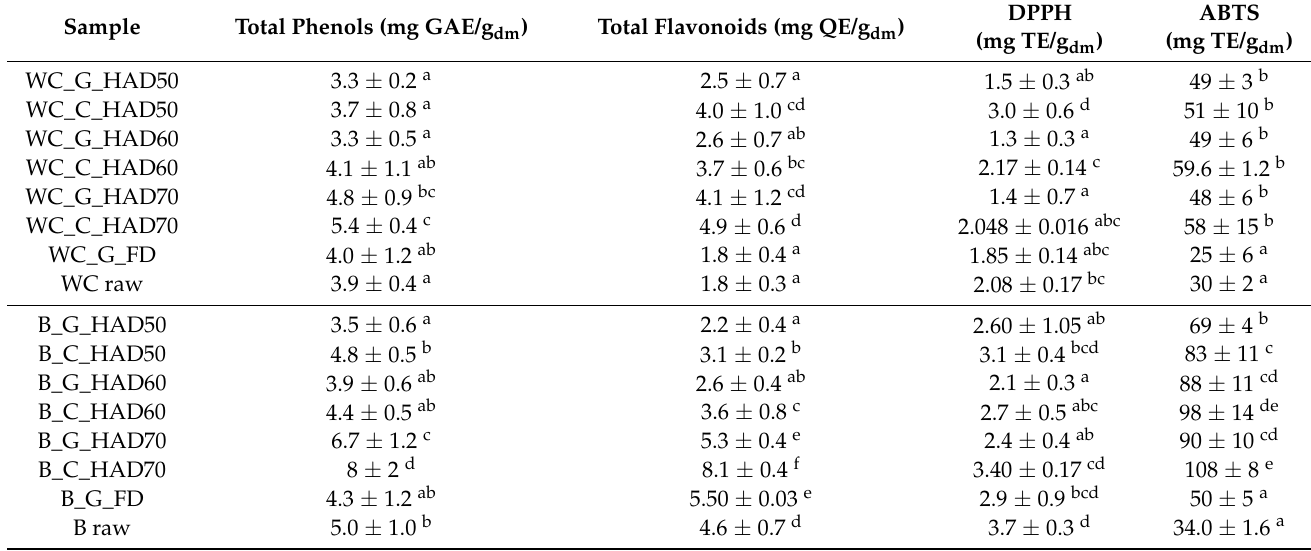
Table 5. Results of antioxidant properties of the raw and powdered residues of white cabbage (WC) and broccoli (B). HAD: hot-air drying at 50, 60 and 70 ◦ C, FD: freeze drying; C: chopped; G: ground. Mean ± standard deviation.